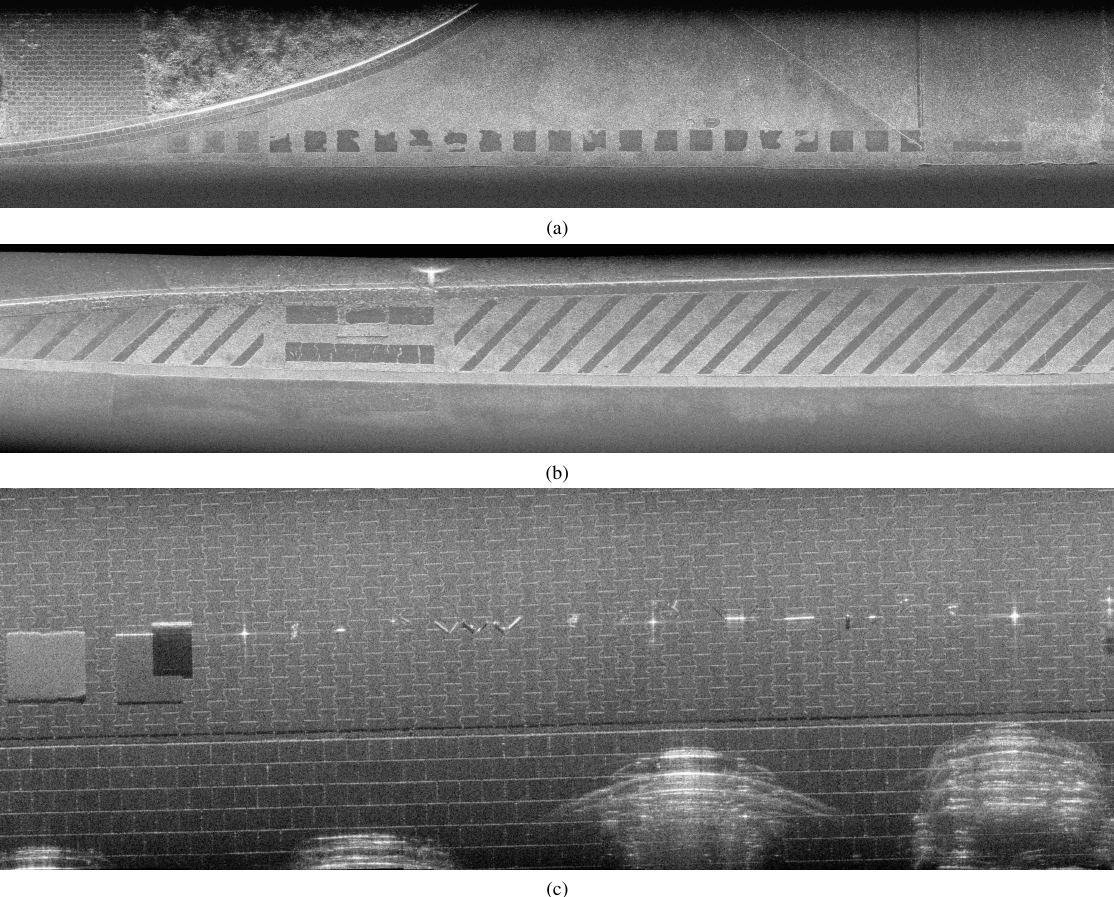
Figure 4: Street Mapping SAR imaging results: The images are sections of considerably longer strips. The streets and parking lanes were passed by at a distance of 5-10 m with a velocity of 20 km/h. The resolution of the SAR images is 5 mm, the stripmap depth about 5 m. (a) Sidewalk (left) and street inter- section (right) with road markings (stop marker of priority road) and small cracks in the asphalt. (b) Bus parking lane with striped ground marking. (c) Experimental setup of different metallic ob- jects placed on a parking lane to test for the resolution and pen- etration capacity of the sensor. On the bottom of the image the front side of parking cars is